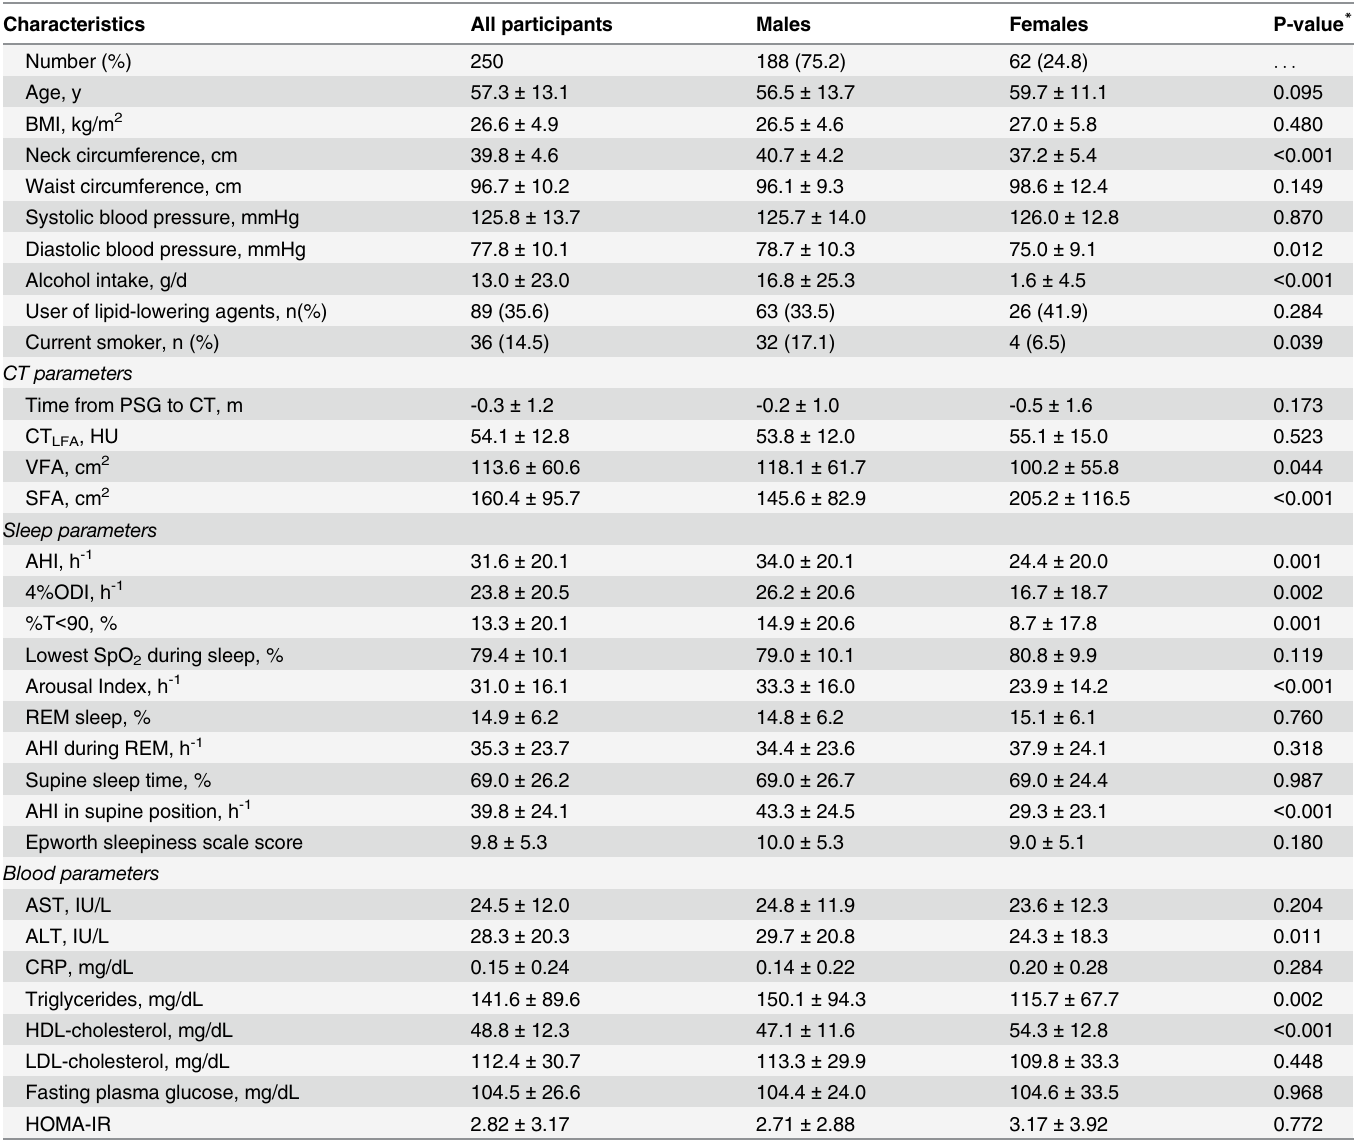
Table 1. Characteristics of study